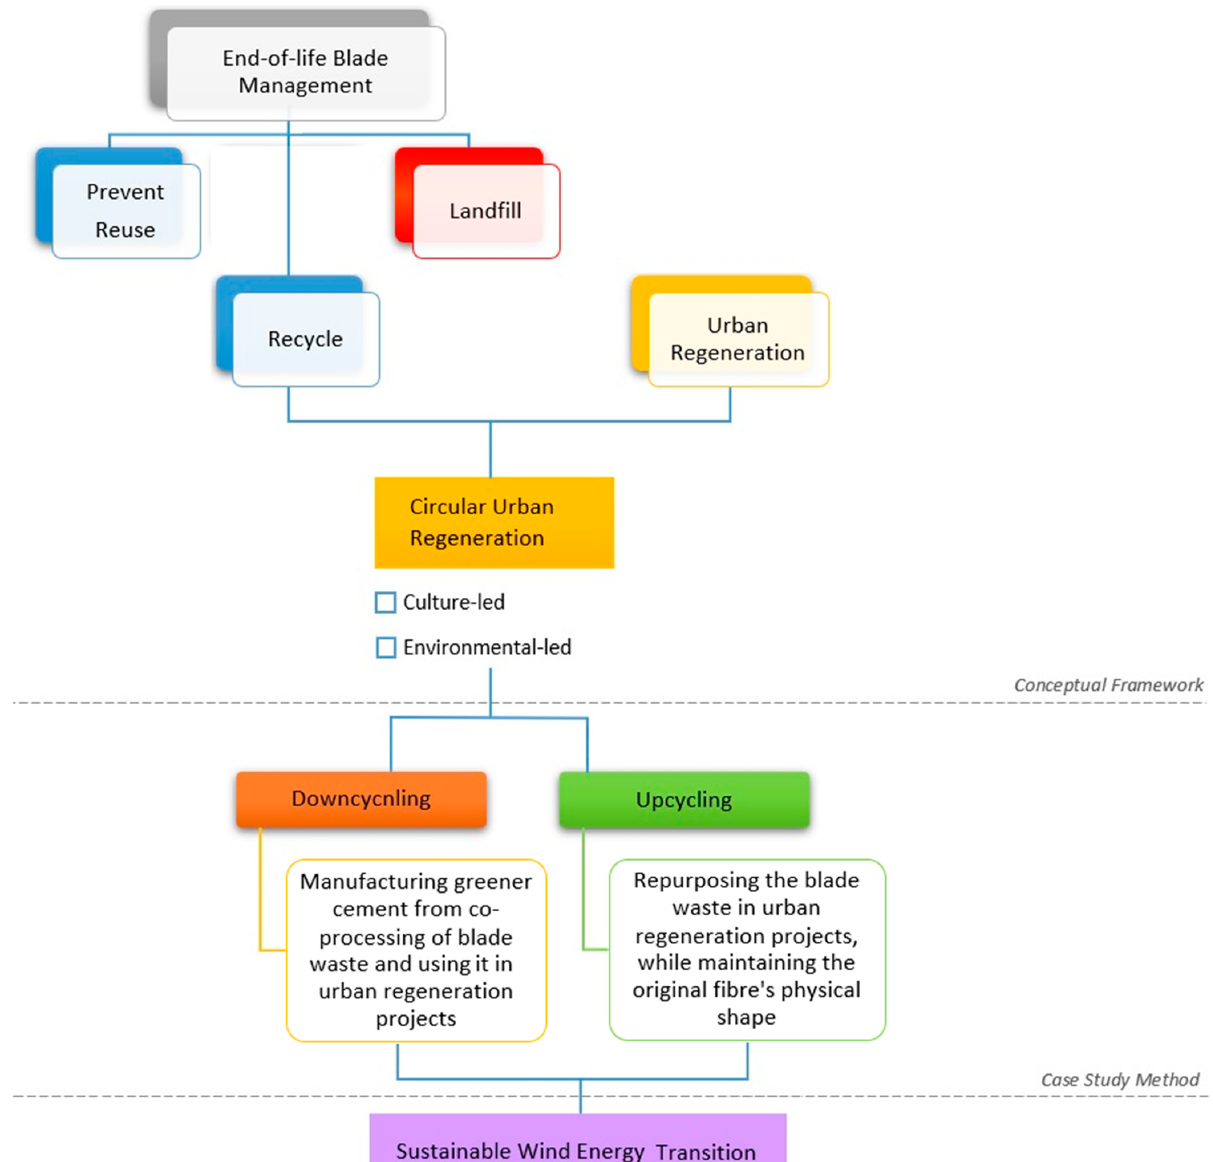
Figure 1. Schematic representation of the methodological framework for end-of-life blade